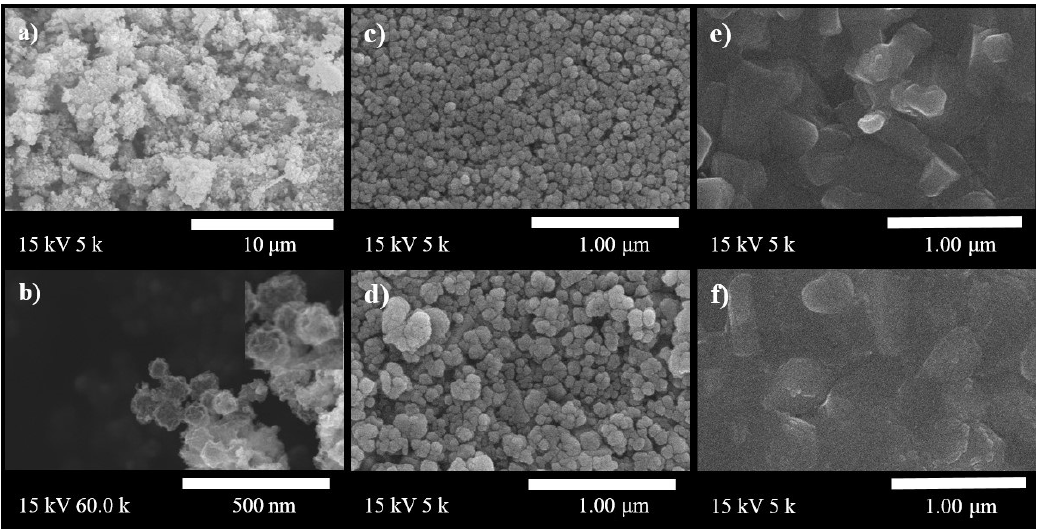
Figure 2. ( a , b ) SEM image of the P25 and TiO 2 hollow powder. ( c , d ) SEM images of commercial TiO 2 (P25) paste and the hollow TiO 2 paste. ( e , f ) SEM images of the FTO/cpTiO 2 /P25 (hollow TiO 2 )/perovskite.